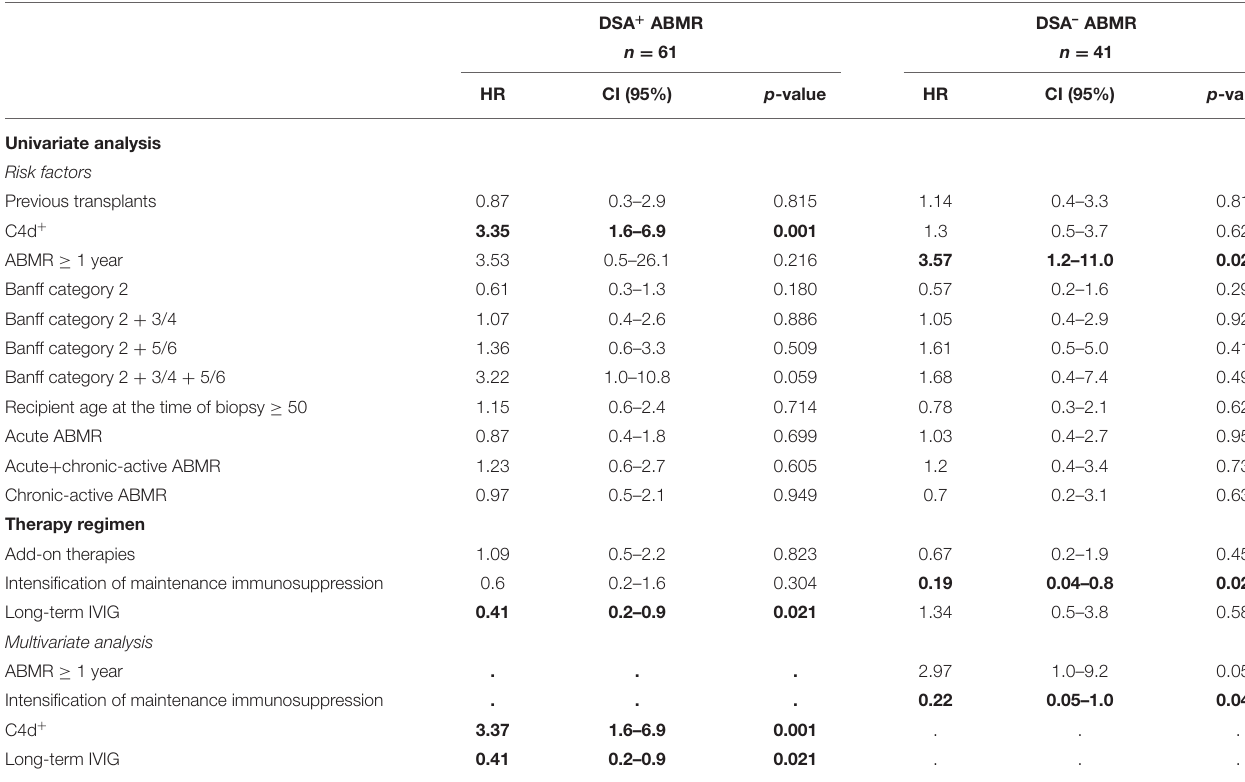
TABLE 4 | Results of univariate and multivariate analyses identifying risk factors for allograft failure and assessing treatment effects of increased maintenance immunosuppression and long-term therapy with IVIG on allograft survival in the subgroup of 61 recipients with DSA-positive ABMR and 41 recipients with DSA-negative